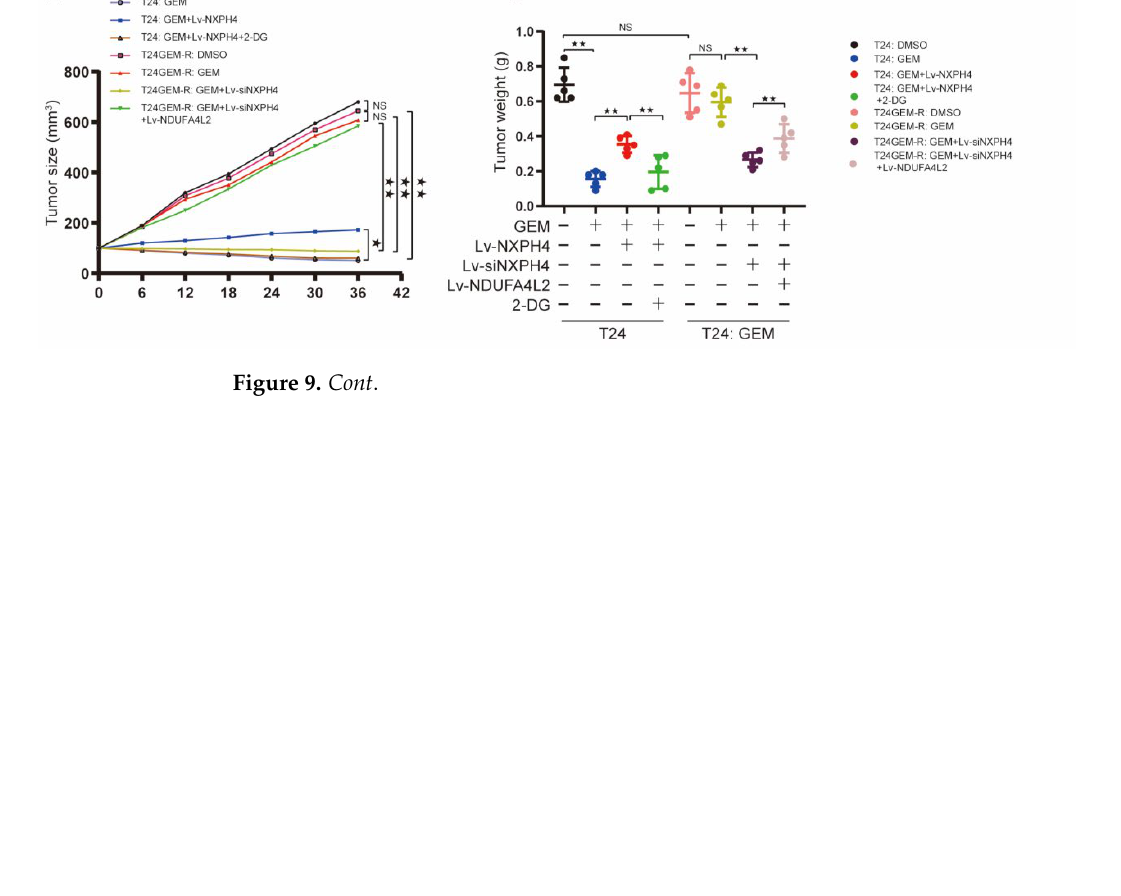
Figure 9. NXPH4/NDUFA4L2 pathway is essential for GEM resistance of BC cells in vivo. ( A – C ) Subcutaneous implantation mouse models were established using parental or GEM-R BC cells